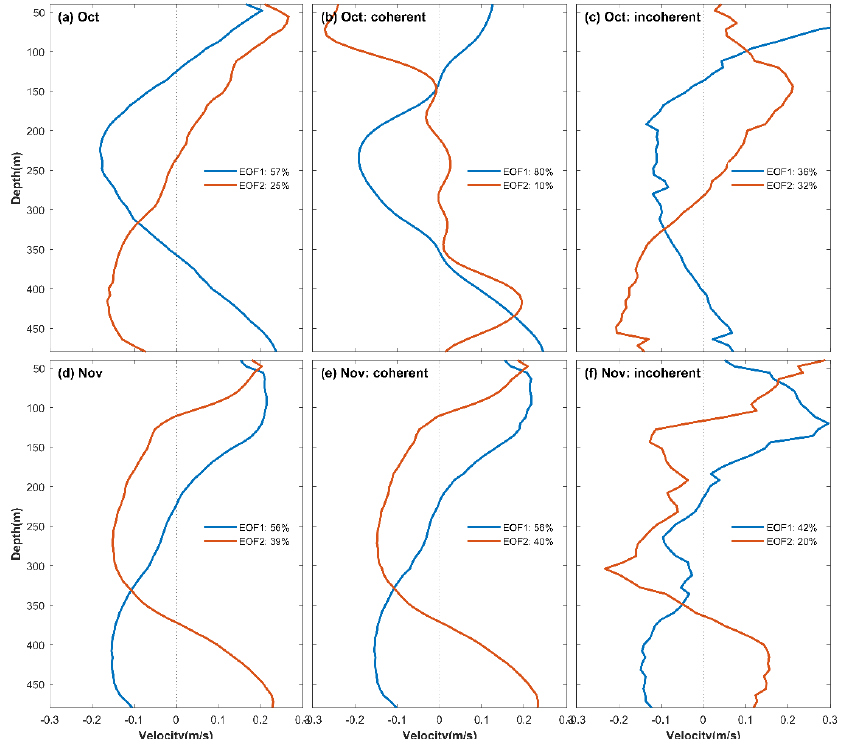
Figure 7. Vertical modes of the ( a ) semidiurnal ITs, ( b ) coherent semidiurnal ITs, and ( c ) incoherent semidiurnal ITs in October, and the vertical modes of the ( d ) semidiurnal ITs, ( e ) coherent semidiurnal ITs, and ( f ) incoherent semidiurnal ITs in November. The blue and orange lines represent the EOF1 and EOF2 of the along-isobath semidiurnal tidal currents, respectively, and the variance contributions of each EOF are denoted by the legends.